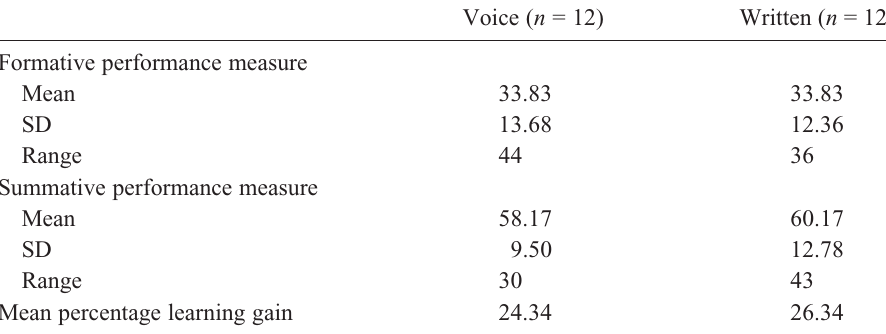
Table 6. Student performance in formative and summative assessments of written and voice